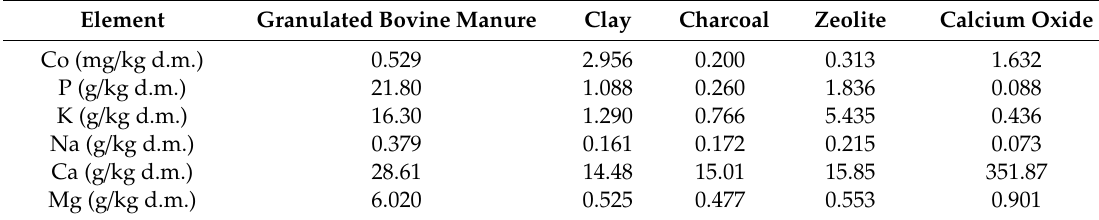
Table 2. Chemical composition of